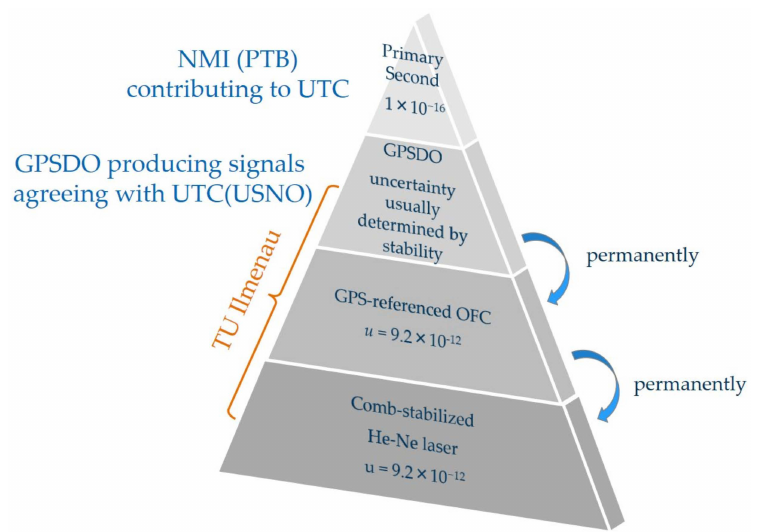
Figure 12. Scheme of the reduced traceability chain for laser wavelength calibration of the metrology lasers of the